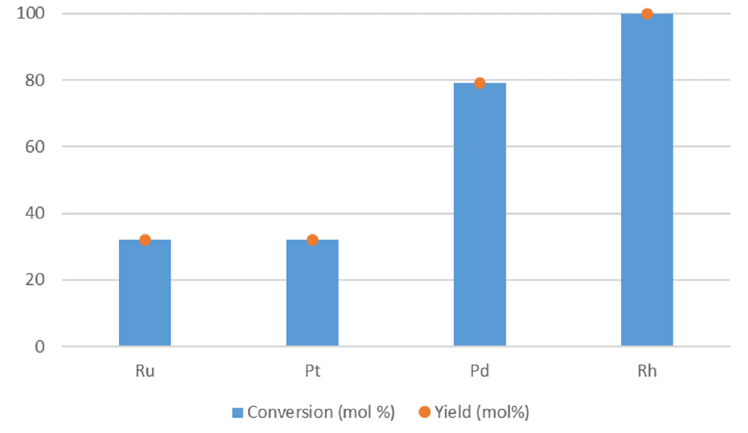
Figure 3. The conversion (mol%, blue) and yield (mol%, orange) of the hydrogenation reactions of fumaric acid in presence of Ru, Pt, Pd and Rh NPs (metal = 0.037 mM) in water at room temperature and pressure with H 2 after 8 h of reaction.